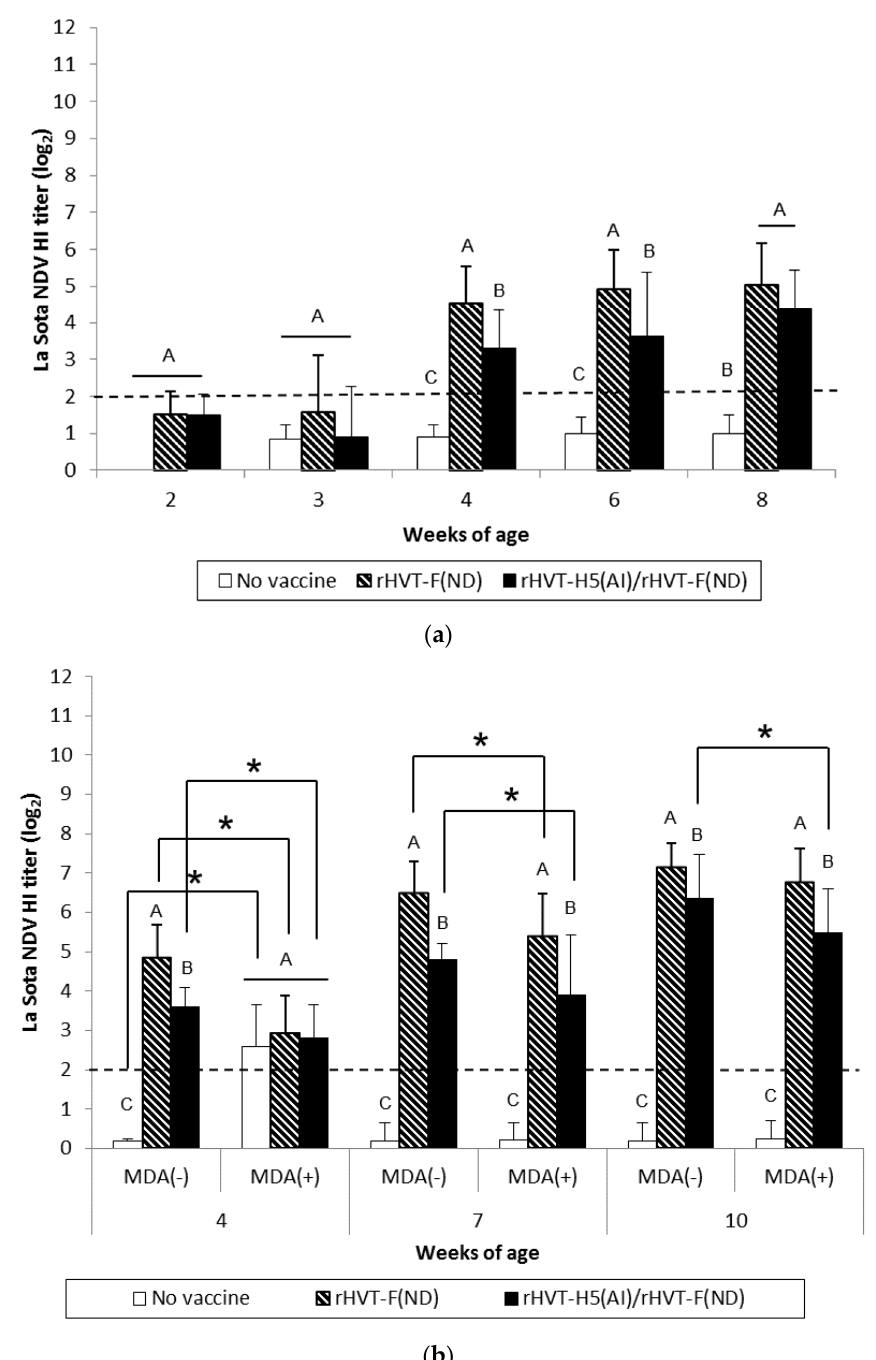
Figure 2. La Sota NDV-HI titers in serum of WL SPF chickens ( a ) and LBL layer chickens ( b ) vaccinated at day-old (experiments I and II, respectively) with rHVT-F(ND) or both rHVT-H5(AI)/rHVT-F(ND) vaccines. Data represent mean ± standard deviation (n = 10–20) of HI titers (log 2 ), which correspond to the last dilution exhibiting inhibition of 4 hemagglutination units of the La Sota NDV antigen. The HI geometric mean titers are expressed as reciprocal log 2 . Titers ≥ 2 log 2 were considered positive (this threshold of positivity is indicated by the dotted line). In figure ( a ), mean ± standard deviation at time points with no common uppercase letters (A, B, C) indicates a significant di ff erence between vaccination schedules ( p < 0.05). In figure ( b ), mean ± standard deviation at time points with no common uppercase letters (A, B, C) indicate a significant di ff erence between vaccination schedules within the MDA group ( p < 0.05), while asterisk superscript symbol (*) indicates a significant di ff erence between MDA(–) and MDA( + ) groups within a given vaccination schedule ( p <